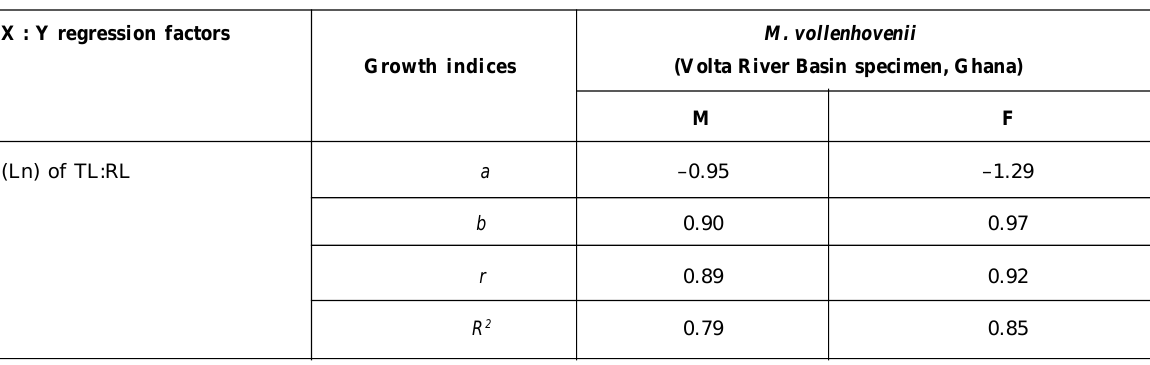
Table 6: Morphometric relationship of M. vollenhovenii collected from Lower Volta River, Ghana using total length and rostral length as regression factors